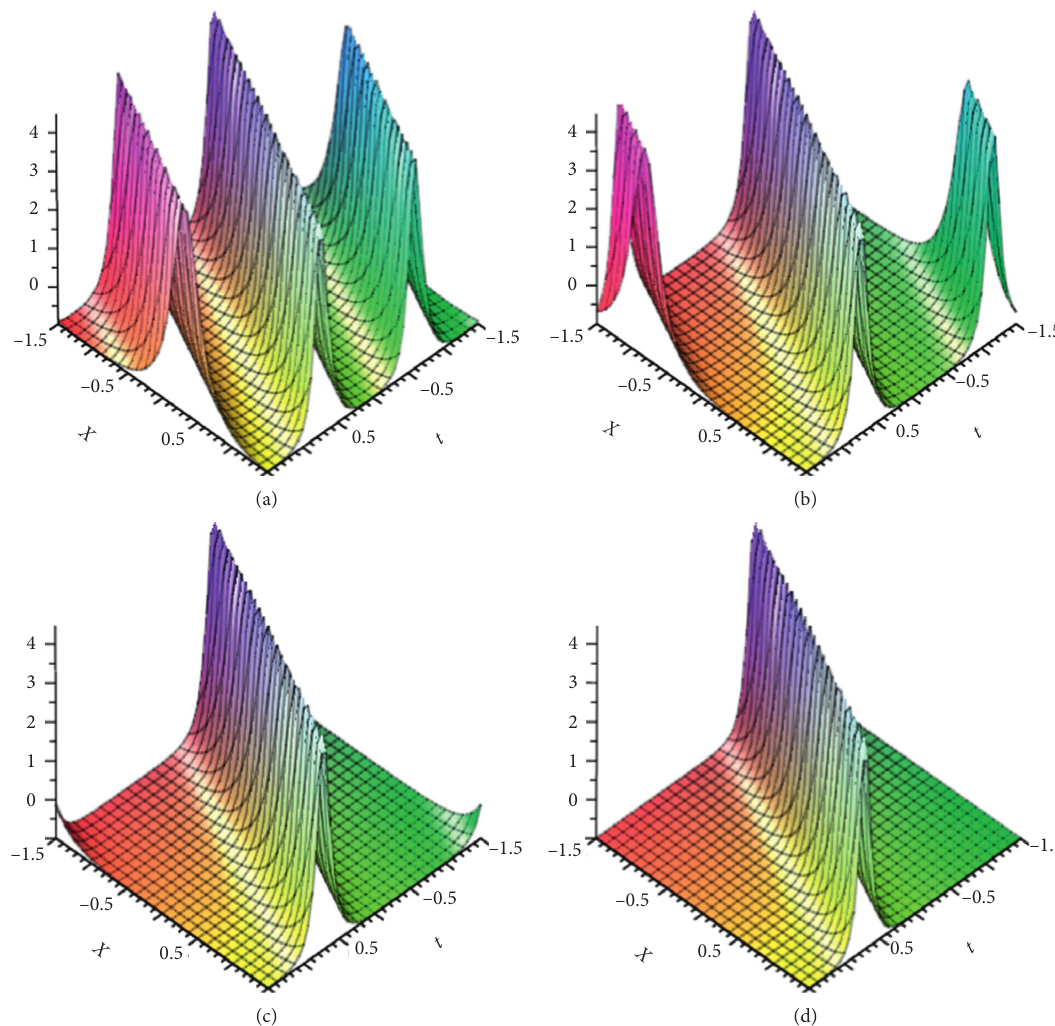
Figure 7: (a) h � 10 . 99 ,u